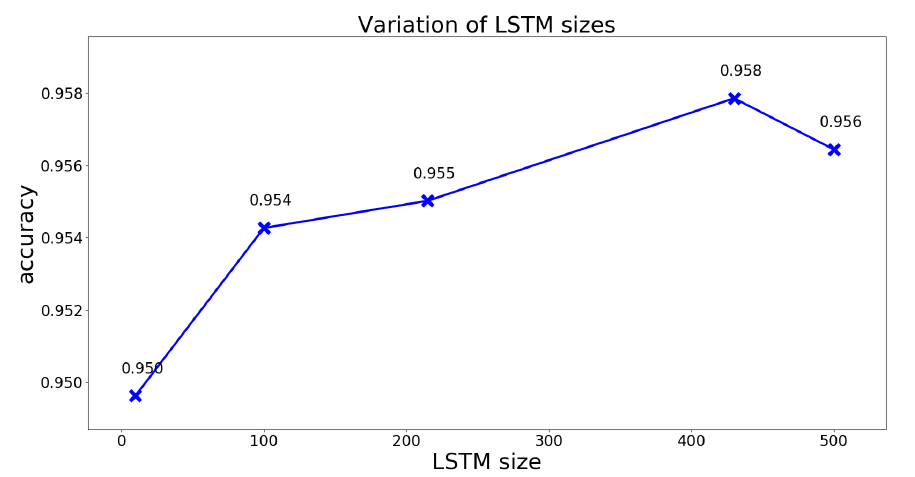
Figure 8. The influence of the LSTM layer size on the result. The test was done with the test dataset, containing unseen data of the test persons that have been involved in the training